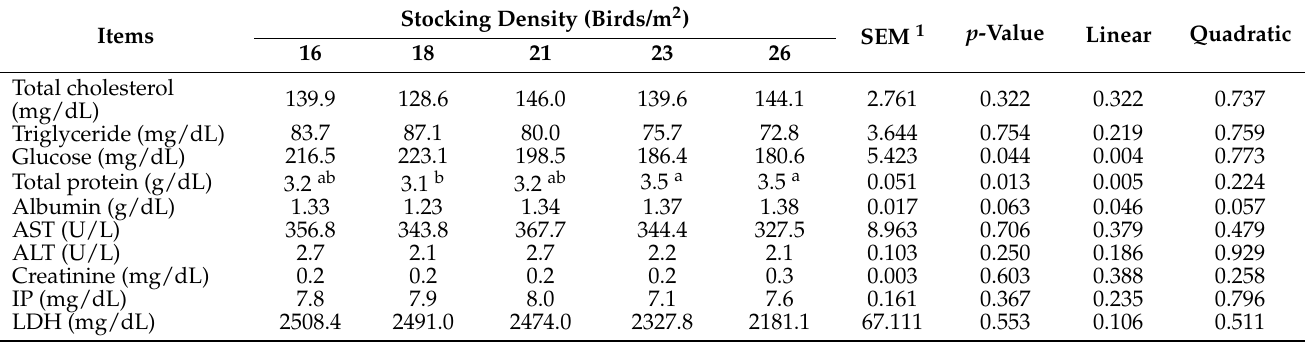
Table 3. Effect of stocking density on blood chemical composition of broiler chickens under high